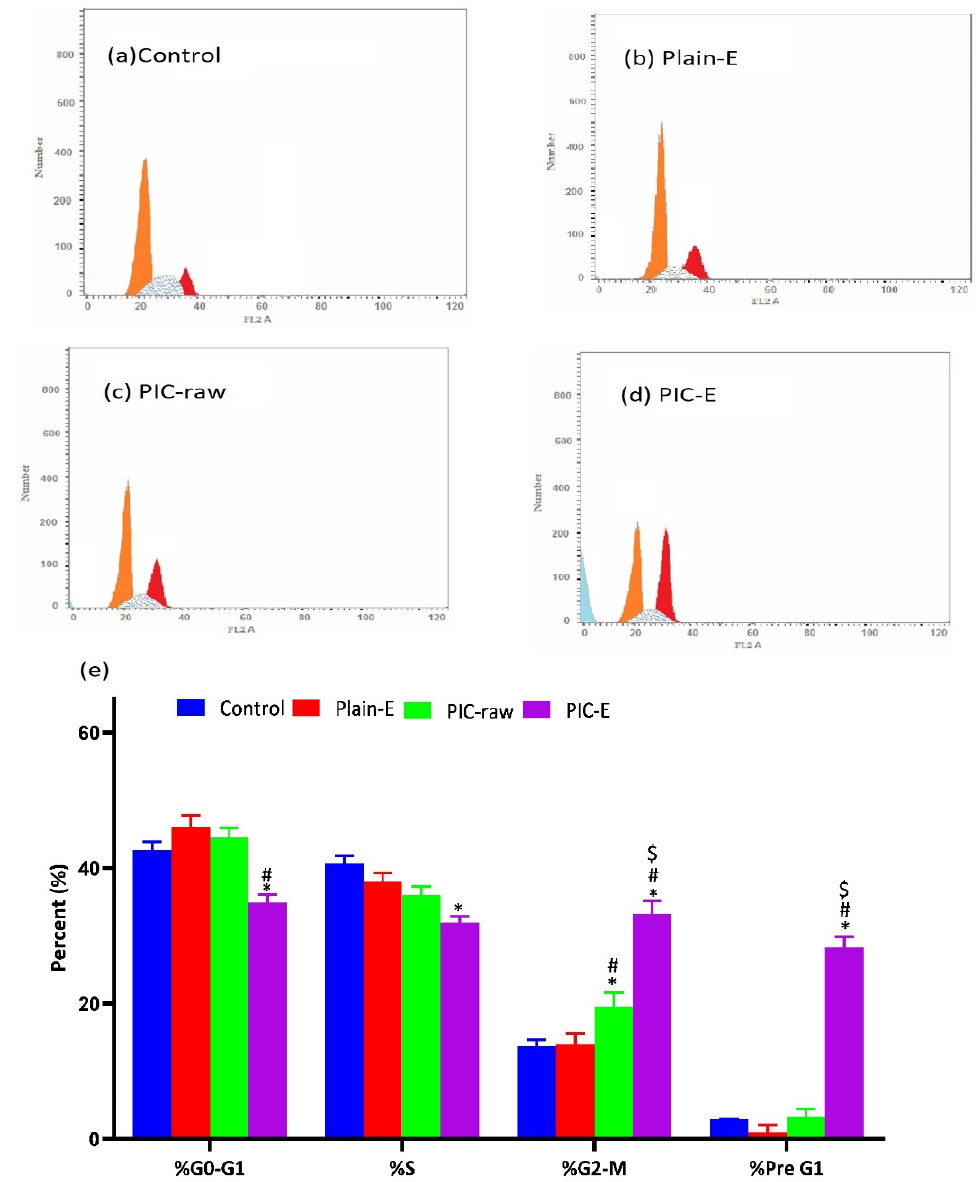
Figure 6. Impact of PIC-E on cell cycle phases of HCT 116 cells. ( a ) Control, ( b ) Plain-E, ( c ) PIC-raw, ( d ) PIC-E, and ( e ) bar diagram of the di ff erent cycle phases. Cells were incubated for 24 h with plain-E, PIC-raw (0.1 µ M) or PIC-loaded E (equivalent to 0.1 µ M PIC). * Significantly di ff erent from control at p < 0.05. # Significantly di ff erent from plain-E at p < 0.05. $ Significantly di ff erent from PIC-raw at p <